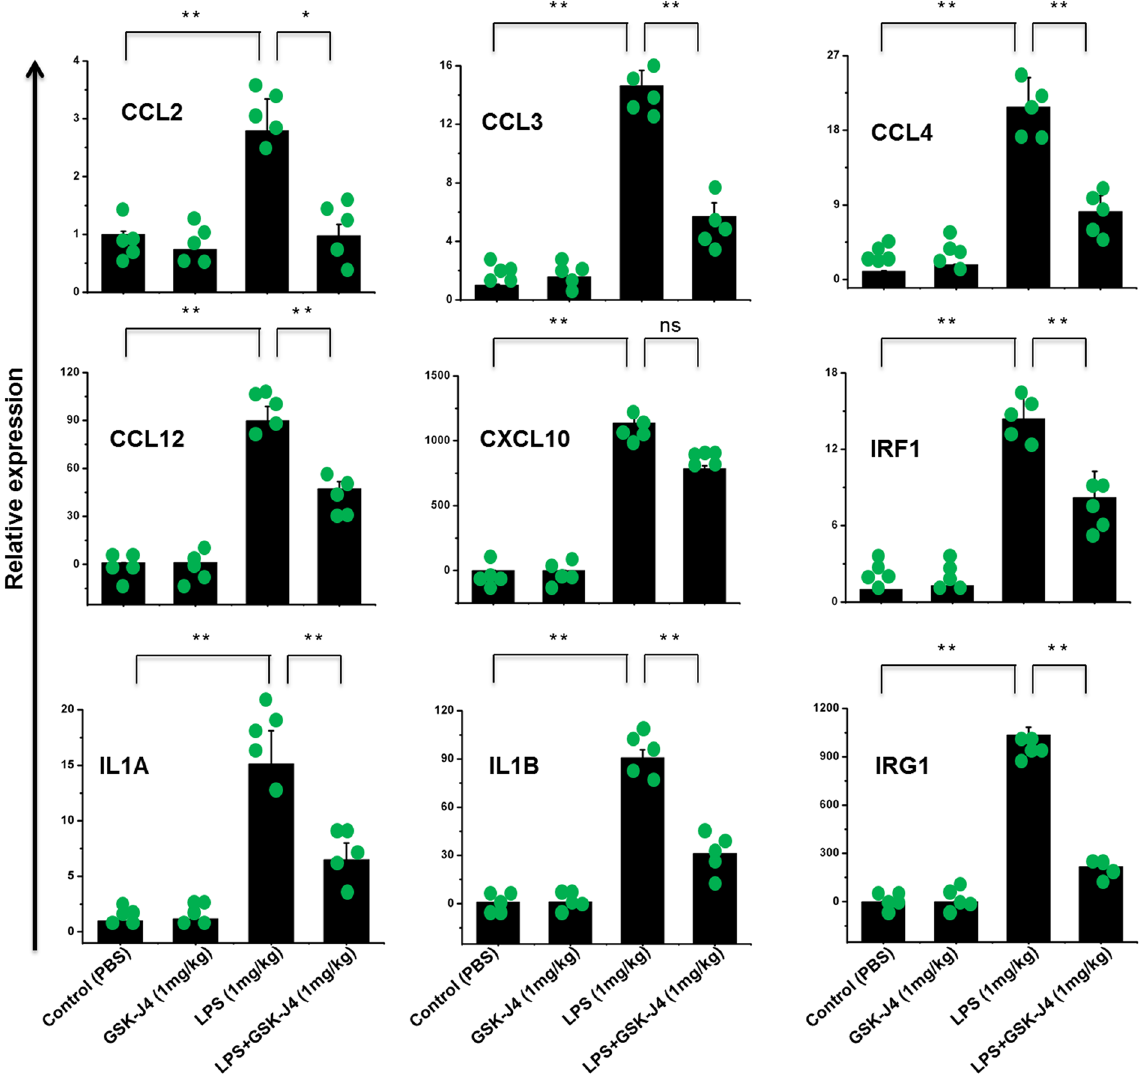
Figure 7. In vivo effect of GSK-J4 on pro-inflammatory responses in LPS-challenged mice. ICR mice (n = 5 for each group) were treated with LPS (1 mg/kg) following GSK-J4 injection (1 mg/kg) and brain microglia were collected at 4-h to determine LPS-induced gene expression by qRT-PCR. The CCL2, CCL3, CCL4, CCL12, IRF1, IL1A, IL1B, and IRG1 genes were significantly down-regulated in the GSK-J4-injected adult microglial cells. Gene expression was normalized to GAPDH transcript levels. Each point represents data from an individual mouse, all values shown as mean ± S.E.M. * P < 0.01, ** P < 0.001 and ns is non-significant versus all other groups; calculated by two-way ANOVA Tukey’s HSD post-hoc